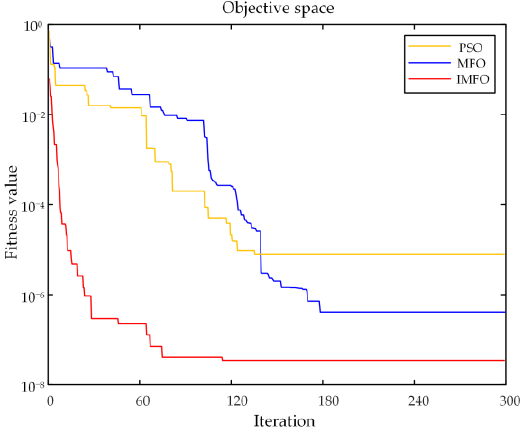
Figure 10. Convergence curves of different algorithms.